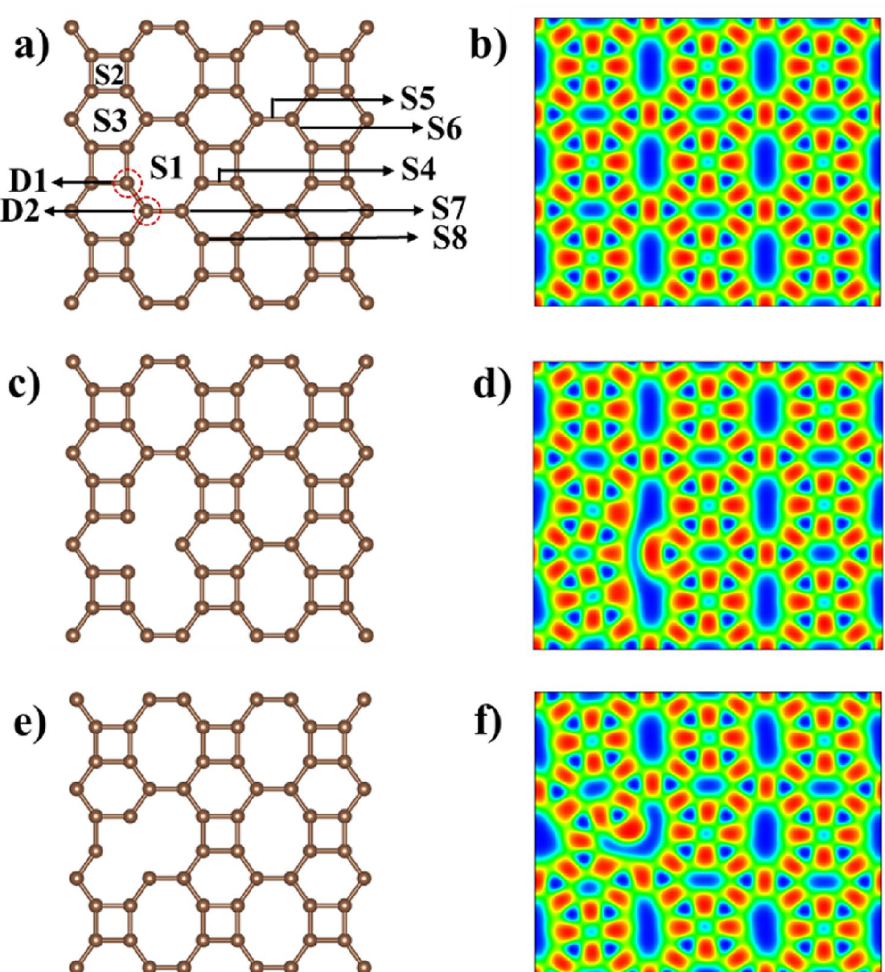
Figure 1. ( a ) Crystal structure of pristine BPN sheet with the possible adsorption sites (S1-S8) ( b ) The electron localization function of pristine BPN sheet ( c , e ) crystal structure of defective BPN sheet, and ( d , f ) the corresponding electron localization function.